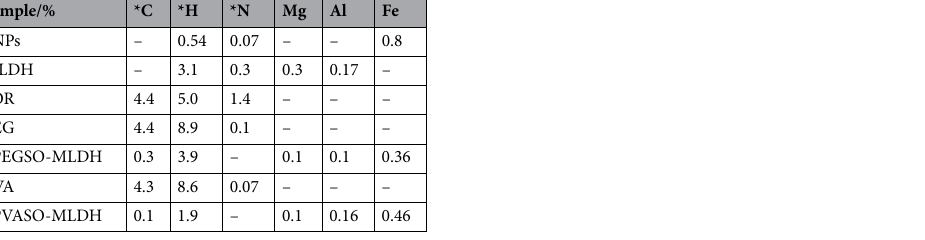
Table 3. Percentage of elements in the